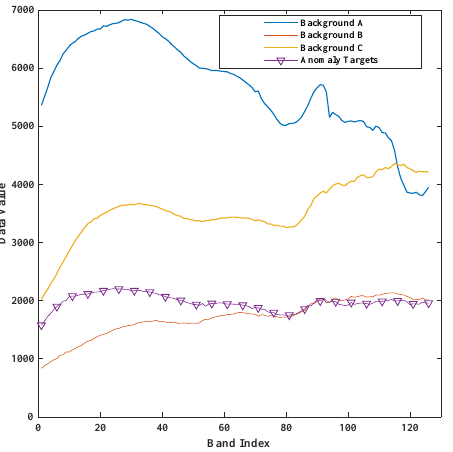
Figure 7. The HSI image of San Jose dataset